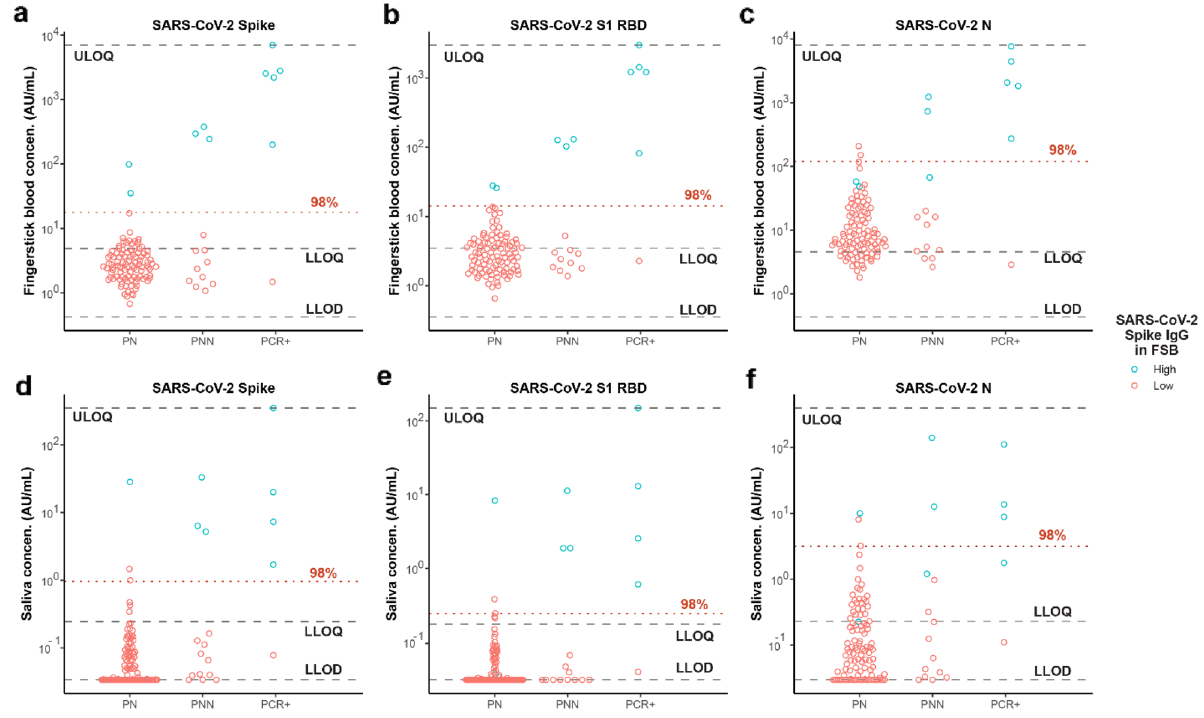
Figure 2. Reactivity to SARS-CoV-2 antigens in self-collected finger-stick blood (FSB) and saliva. Concentrations of anti-SARS-CoV-2 IgG antibodies are plotted for donors who have been grouped based on survey responses about CoV-2 infection, exposure, and symptoms as detailed in Table 1. Dashed lines indicate assay sensitivity and quantitation (LLOD = lower limit of detection; LLOQ = lower limit of quantitation; ULOQ = upper limit of quantitation). The red dotted line labeled “98%” is drawn at the threshold set at the 98th percentile for the presumed naïve (PN) donors. Blue indicates donors whose IgG levels in finger-stick blood exceeded the threshold for SARS-CoV-2